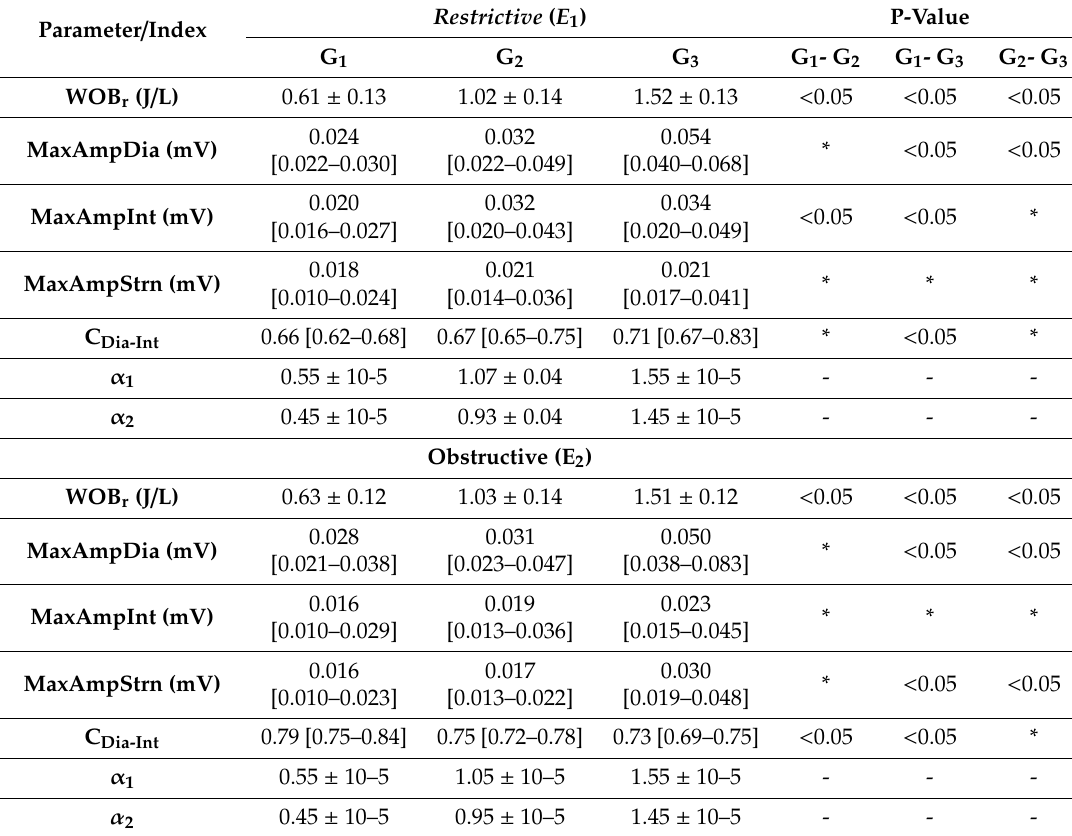
Table 4. Median and standard deviation of real work of breathing values for each group. G1: Low WOB; G2: medium-high WOB; G3: elevated WOB. Furthermore, the parameters of each model and the selected index values for classification model are